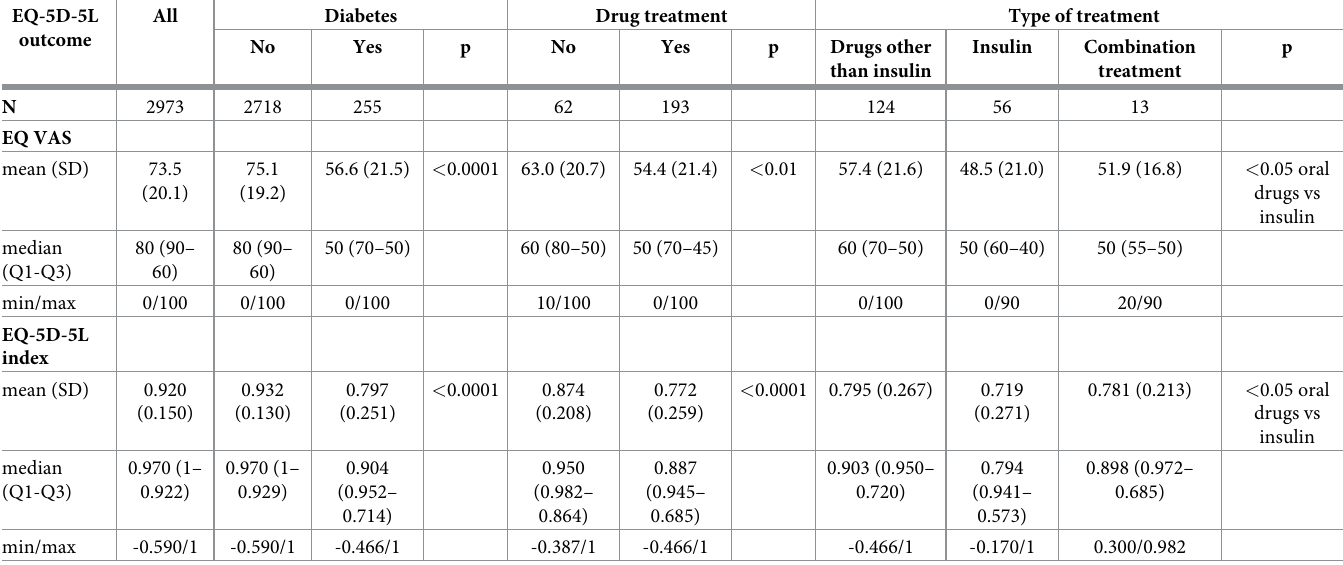
Table 4. EQ VAS and EQ-5D-5L index according to diabetes and treatment status. EQ-5D-5L